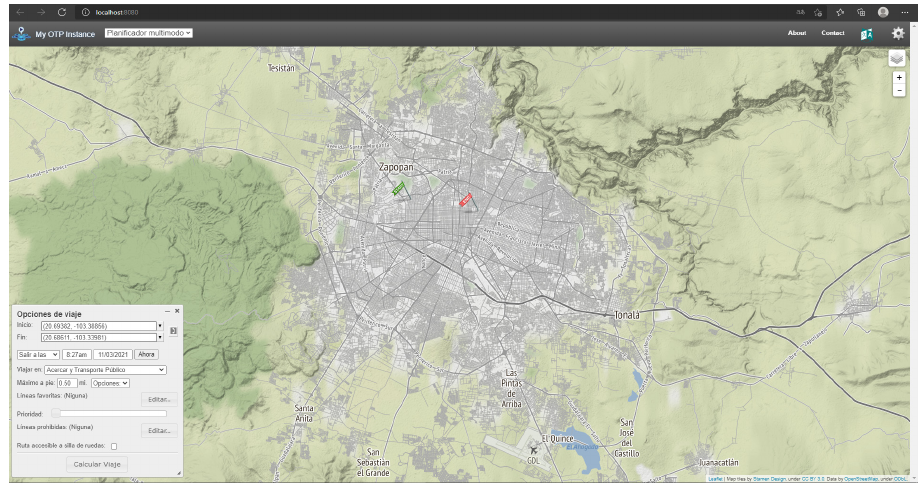
Figure 6. Example of the graphical view of OTP